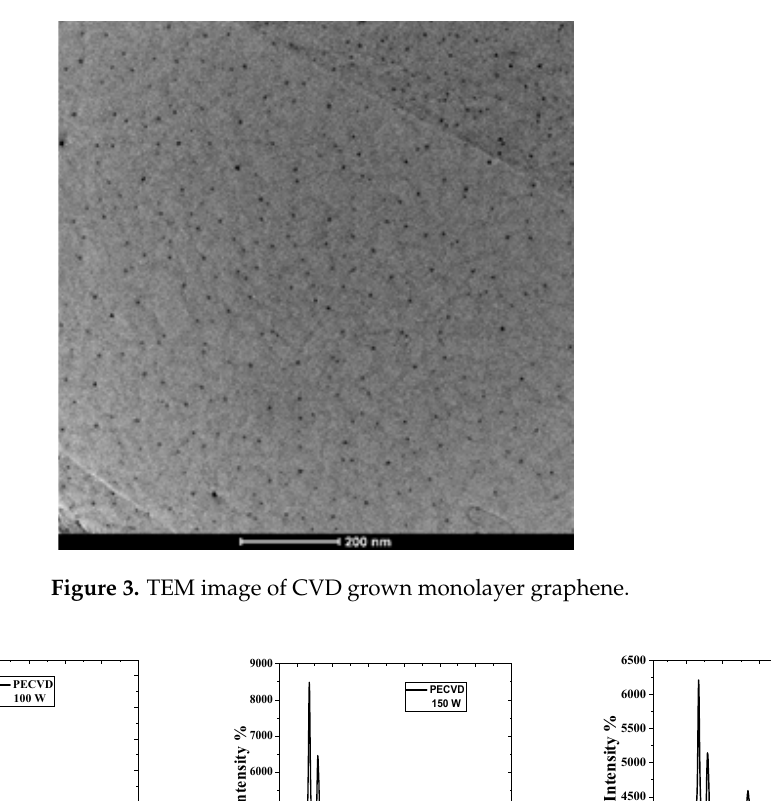
Figure 3. TEM image of CVD grown monolayer graphene .